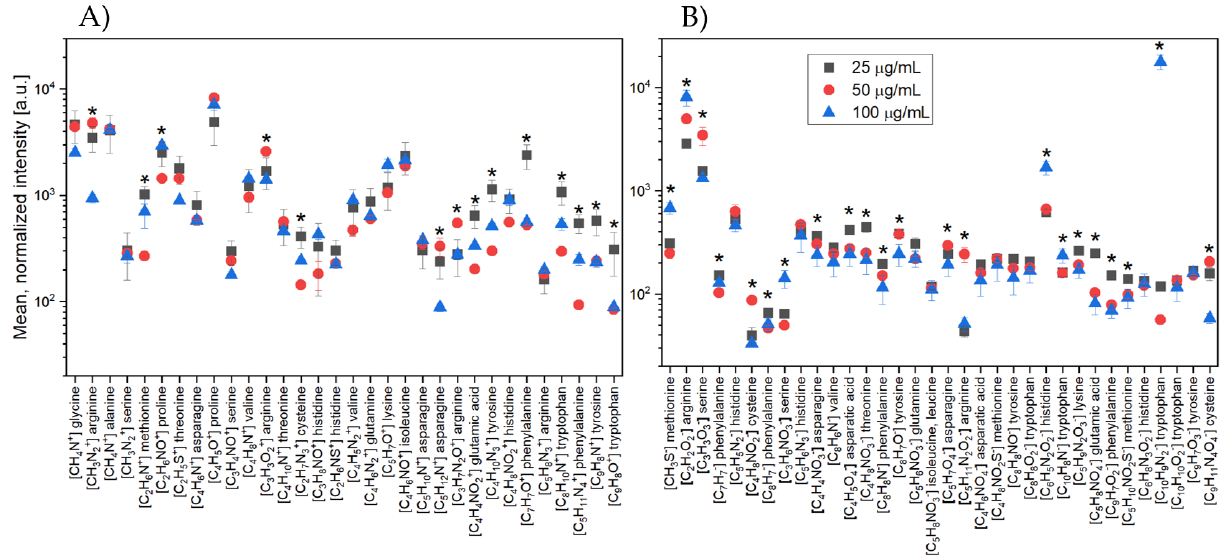
Figure 6. Values of the mean normalized intensities for the characteristic amino acid peaks in the case of ( A ) positive and ( B ) negative ions for the three concentrations of LACT deposited on the surface of functionalized silicon with GOPS. The index “*” means a statistically significant difference at the level of p = 0.05 for the studied groups.